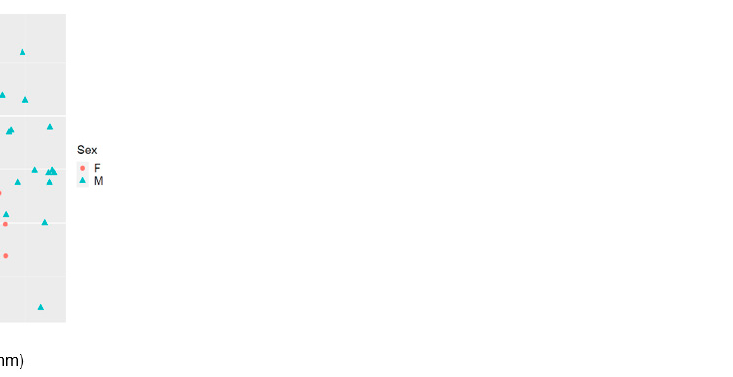
Figure A1. Adult fresh mass between trials (T1 = Trial1, T2 = Trial2) in females and males of Pieris napi .